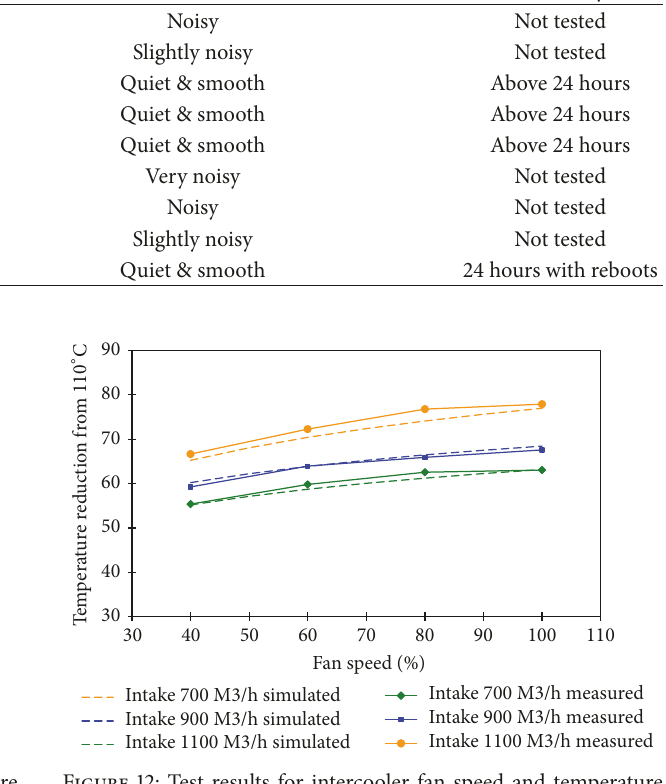
Figure 12: Test results for intercooler fan speed and temperature